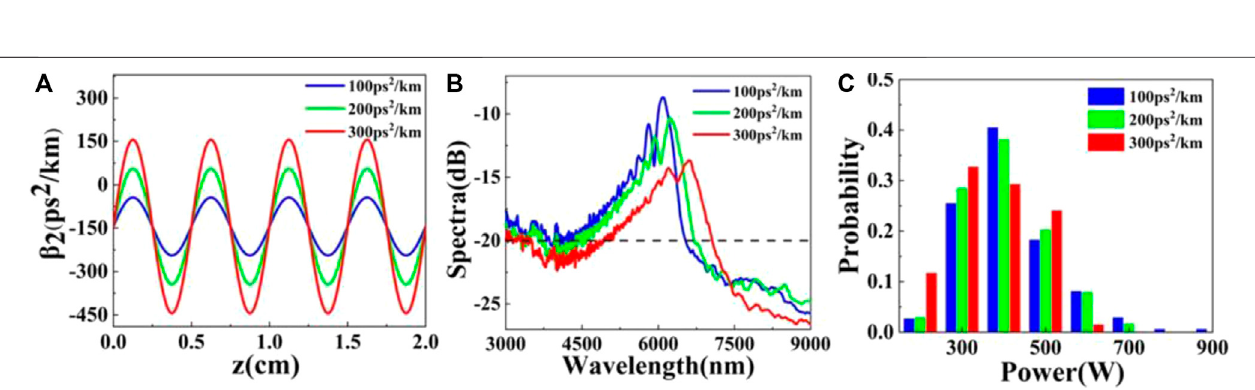
FIGURE 5 | (A) Dispersion curves of DOF, (B) output mean spectra of the DOF, (C) histograms of the peak power beyond 7,000 nm of the output spectra in DOF with different oscillation amplitudes ( P 0 (cid:2) 1.224 kW, Λ (cid:2) 0.5 cm, φ (cid:2) 0).